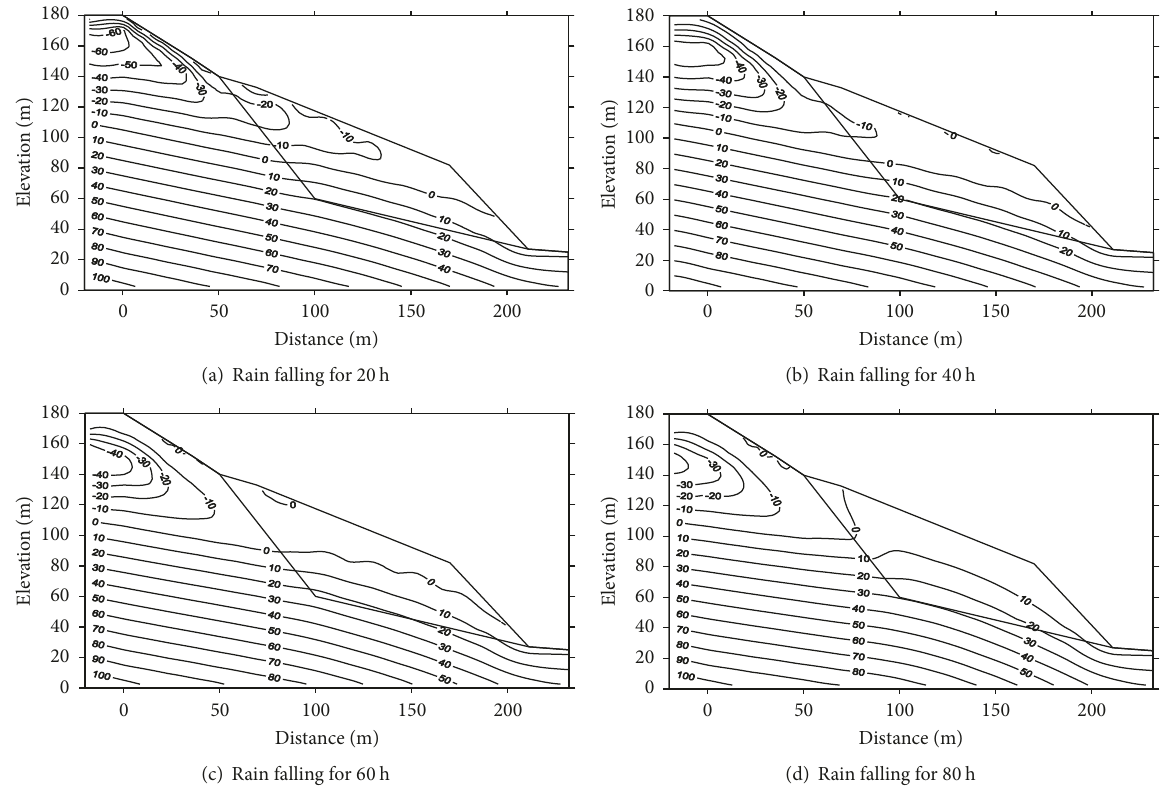
Figure 9: Pressure head contours of rainfall intensity 20mm/h.